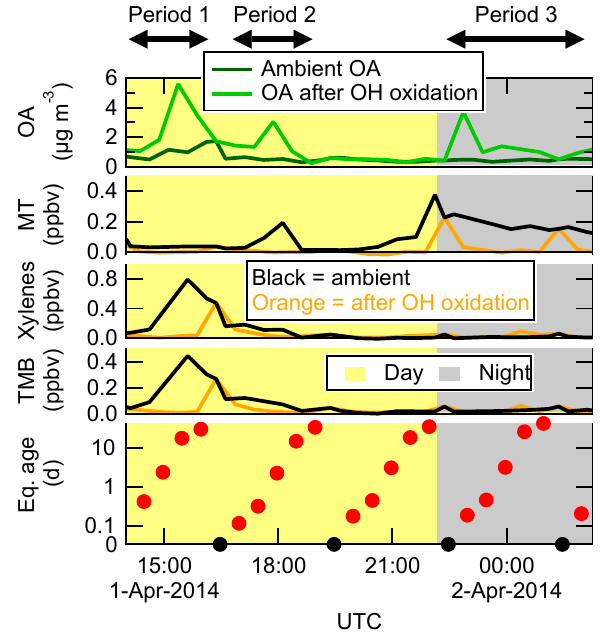
Figure 4. An example of OA concentrations in ambient air and af- ter OH oxidation of ambient air in the OFR at the T2 site, shown together with MT, xylenes, and trimethylbenzene (TMB) measured in ambient air and after OH oxidation. The OH exp is also shown (in eq. days). Daytime (nighttime) hours are indicated with the yellow (grey) background. OH age was cycled through a range of expo- sures, including no added exposure (black circles) where none of the VOCs were reacted in the OFR. This example illustrates how SOA formation in the OFR can come from urban (Period 1), bio- genic (Period 3), or mixed (Period 2) precursors, depending on am- bient